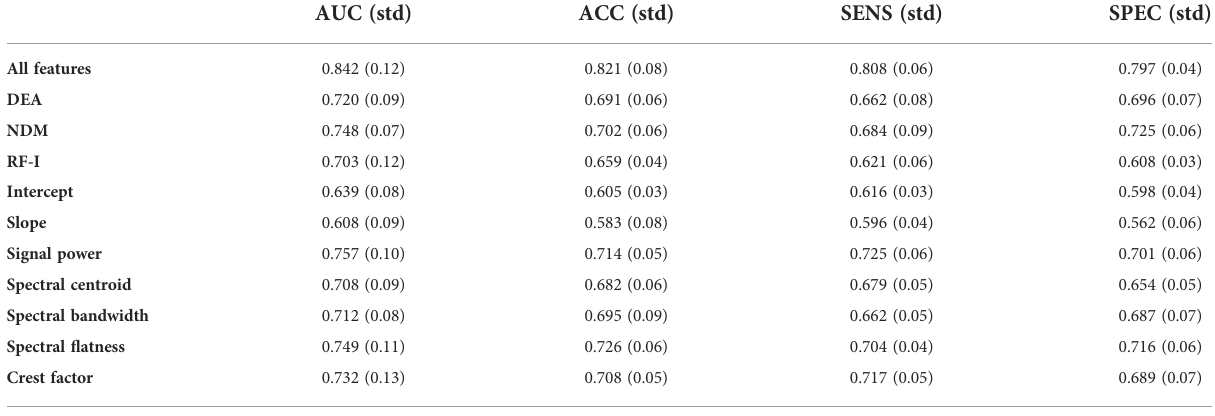
TABLE 4 The classi fi cation results of different feature sets.